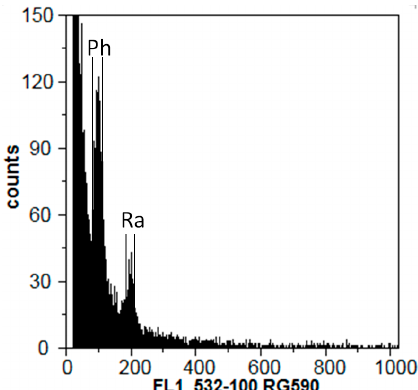
Figure 4. Histogram showing flow cytometric analysis of relative fluorescence intensities (FL1) of propidium iodide-stained nuclei simultaneously isolated from rust-infected daylily plants [ Hemerocallis sp. (nuclei out of scale) and Puccinia hemerocallidis (Ph) isolate Ph02] and the DNA reference Rhamnus alaternus (Ra).